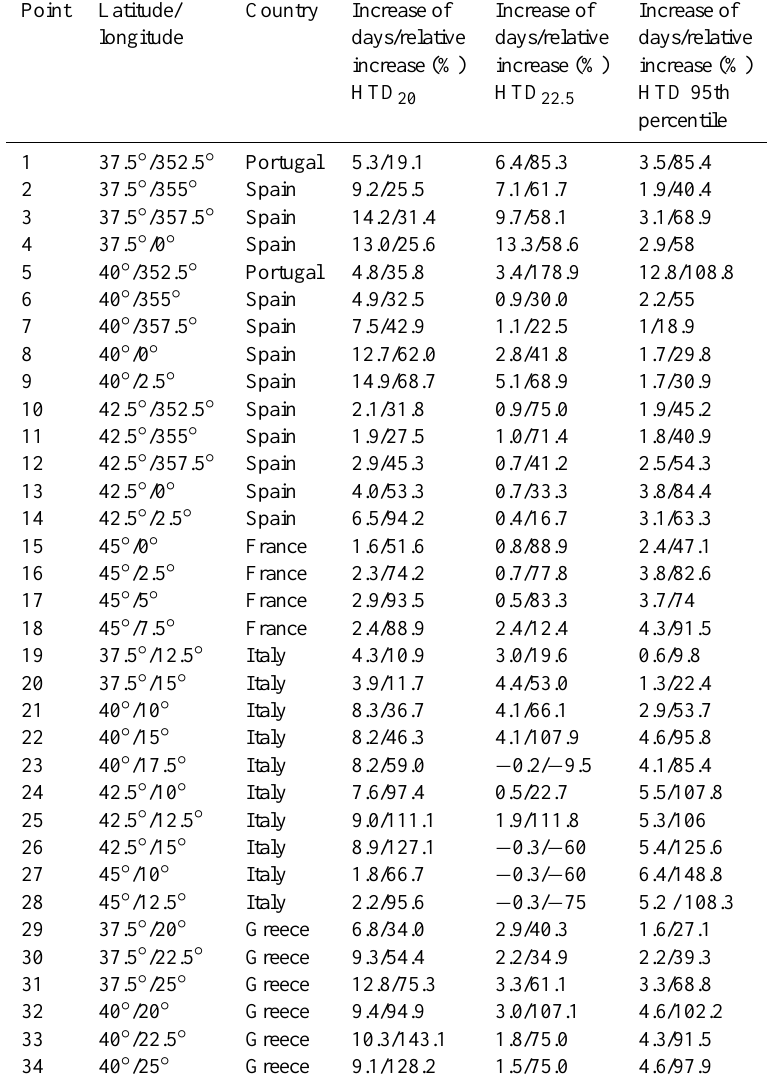
Table 2. Increase from 1978–1987 to 2002–2012 decades in both number of days and relative increase in number of days of HTD 20 , HTD 22 . 5 , and the 95th percentile (June–September